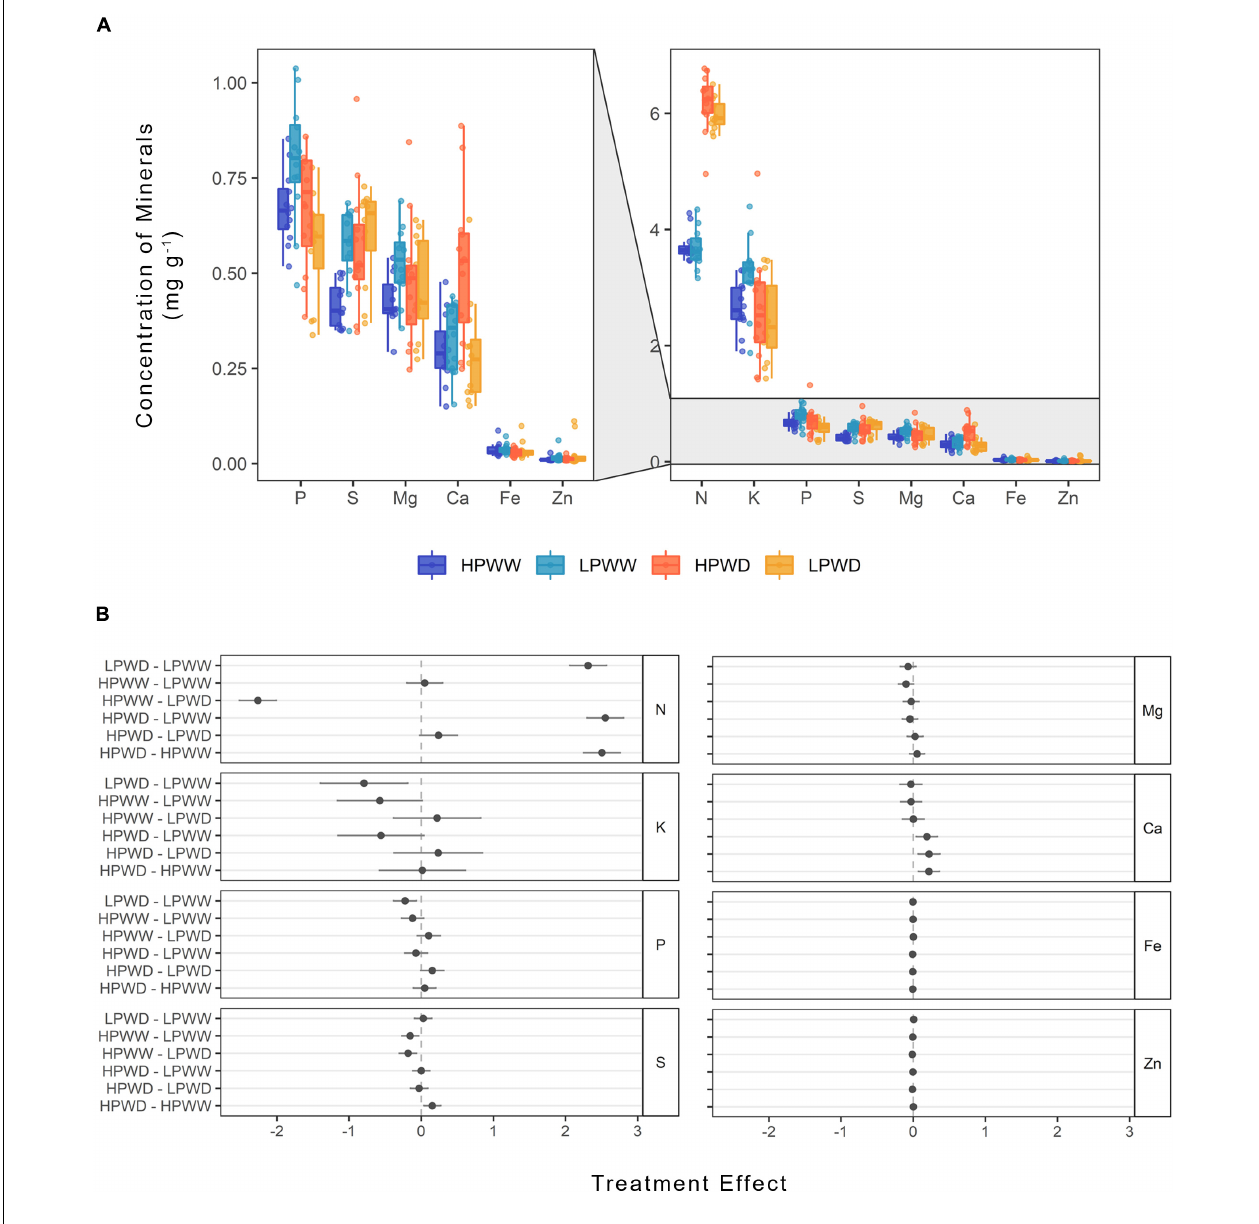
FIGURE 7 | (A) Concentration (mg/g) of nutrients found in the common bean seed subjected to high phosphorus well-watered (HPWW; blue), low phosphorus well-watered (LPWW; light blue), high phosphorus water deficit (HPWD; orange), and low phosphorus water deficit (LPWD; yellow-orange) at harvest. Zoom in panel to the left shows nutrients that had concentrations less than 1 mg/g. (B) Comparison of treatment effect combination on the concentration of nutrients. Dots represent mean value with upper and lower confidence level; x-axis shows the mean difference in the concentration of nutrients between the treatments; vertical dash lines illustrate 0 effect, where values close to 0 are not significantly different according to the HSD test at A =